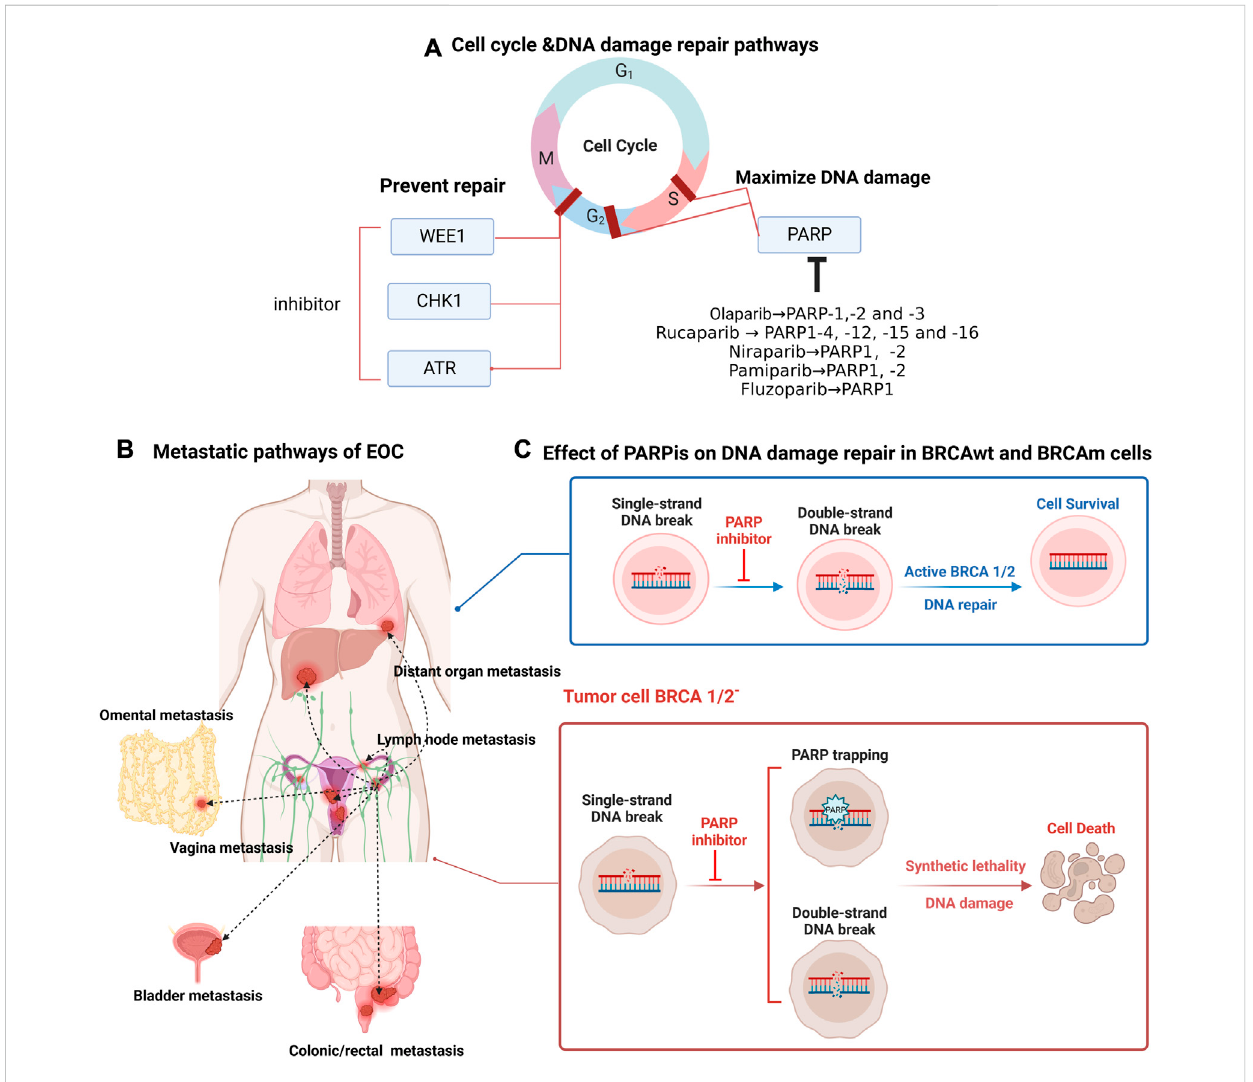
FIGURE 3 Targeting ovarian cancer cell cycle and DNA damage repair pathways, distant metastatic sites in ovarian cancer, principles of action of PARP inhibitors. (A) PARPproteinsareinvolvedinS-phaseandG2-phaserepairofthecellcycle.PARPisamplifyDNAdamage,andthecommontypesofPARPis and their acting PARP proteins are described here; the main loci involved in G2-phase repair include WEE1, CHK1 and ATR, and the design of correspondinginhibitorscanhelppreventDNAdamagerepair. (B) Commonmetastaticpathwaysinepithelialovariancancerinclude:directinvasion of adjacent organs (vagina, bladder, rectum/colon, contralateral ovary); implantation metastases in the omentum and abdominal cavity; lymphatic metastasesandhematogenousmetastasesinvolvingdistantorgans. (C) Poly(ADP-ribose)polymerase(PARP)proteinrecognizesandrepairsDNAsingle- strand breaks (SSBs), and unrepaired SSBs are converted to double-strand breaks (DSBs) with PARPi, which relies on the homologous recombination repair pathway for cell survival; in the presence of homologous recombination defects, including BRCA1/2 mutations, double-strand breaks cannot be repaired, causing cell